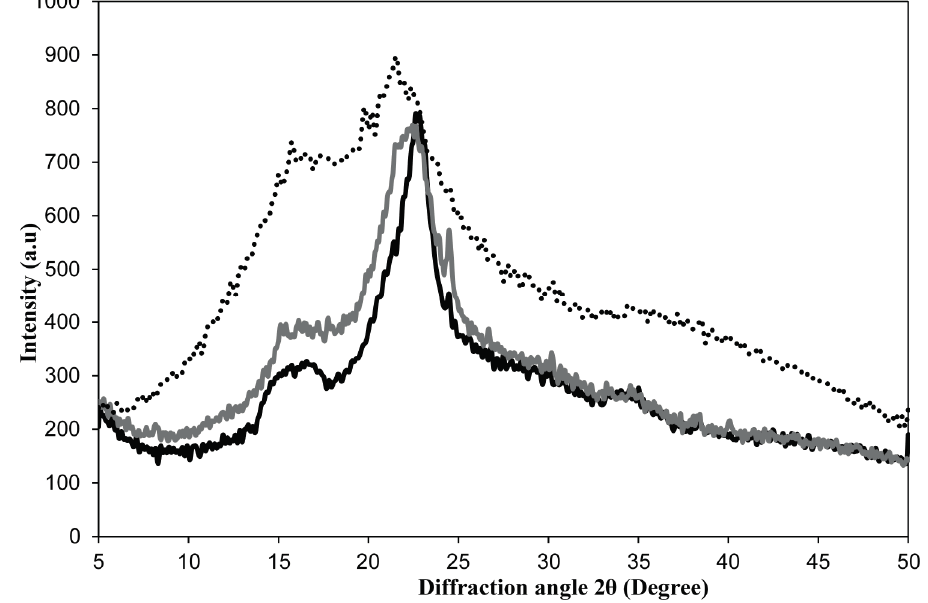
Figure 4. X-ray diffractograms of Citrus-waste Biomass (CB) as raw material (dashed line), nanocellulose obtained by the physicochemical method of delignification and bleaching using NaOH and NaClO 2 (gray) and after enzymatic treatment for 48 h at 45 °C (black). Other reports [12,32] present data on cotton nanofibers, which have an average crystallinity